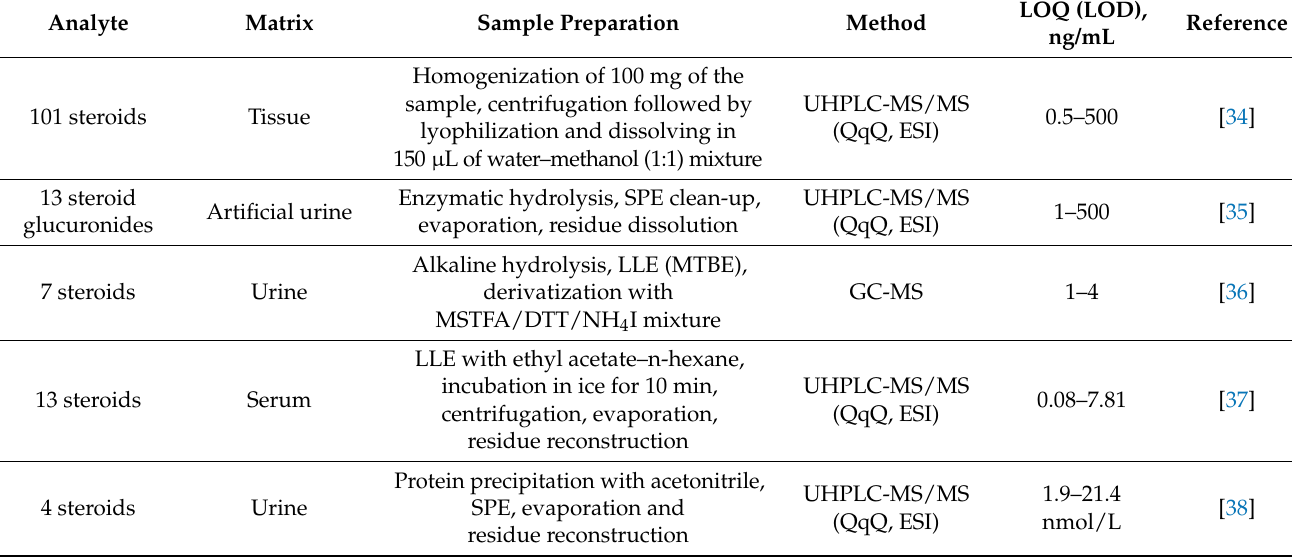
Table 1. An overview of some methods for the determination of